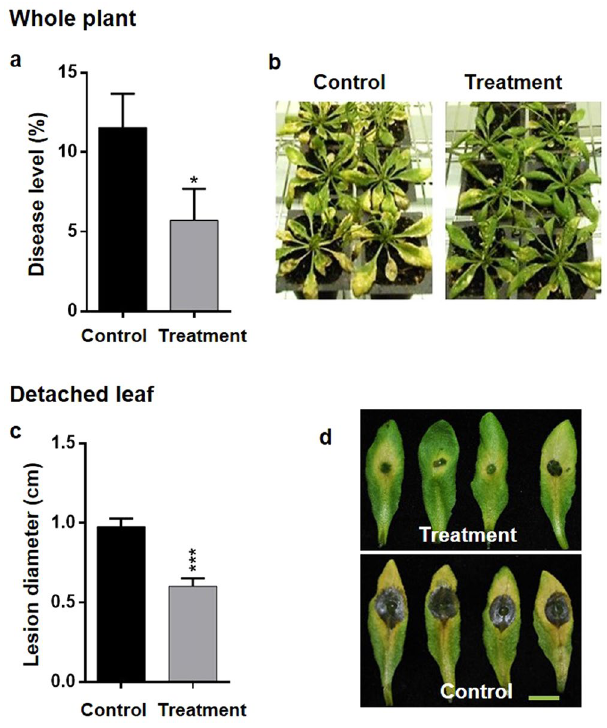
Figure 1. Reduction of disease symptoms after infection with B . cinerea in A . thaliana exposed to 1000 Hz sound vibration. (a) Percentage of disease level in whole plant assay. Percentage of disease level was calculated by counting fully senescent leaves at 72 h post inoculation (hpi). Bars represent mean and standard error of four biological replications. (b) The disease phenotype of whole plants at 72 hpi. Plants exposed to sound vibration (daily 3 h for 10 days, treatment) and control were inoculated with fungal spores and kept under growth room condition with high humidity. (c) Lesion diameter in detached leaf assay. Lesion diameter was measured at 72 hpi. Bars indicate the means of the lesion diameter with standard errors in 40 detached leaves. (d) The lesion phenotype of detached leaves. Detached leaves exposed to a 1000 Hz sound vibration (upper) and control (lower) at 72 hpi of B . cinerea spores. bar = 1 cm. P -value ranges are marked by asterisks: *** P < 0.01, ** 0.01 < P < 0.05, * P <